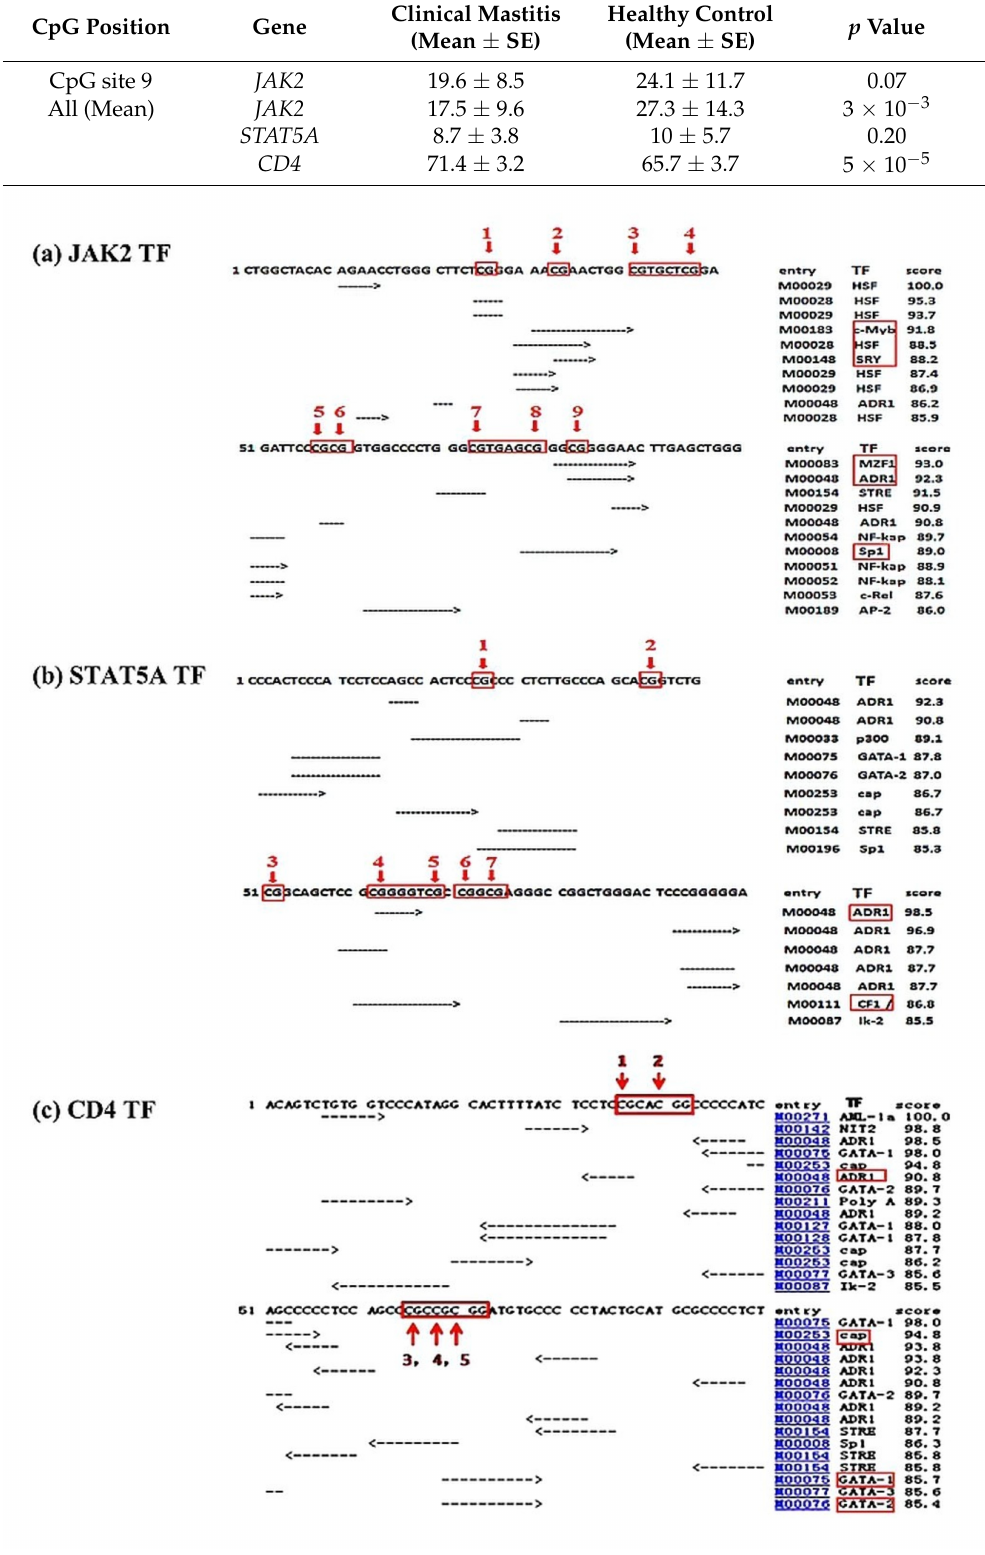
Figure 2. Predicted binding sites of transcription factors in the 1 kb promoter region of different genes under study: ( a ) JAK2 , ( b ) STAT5A , ( c ) CD4. Number with red arrows indicate the CpG sites in the 1 kb promoter region of the studied genes. TF, predicted transcriptional